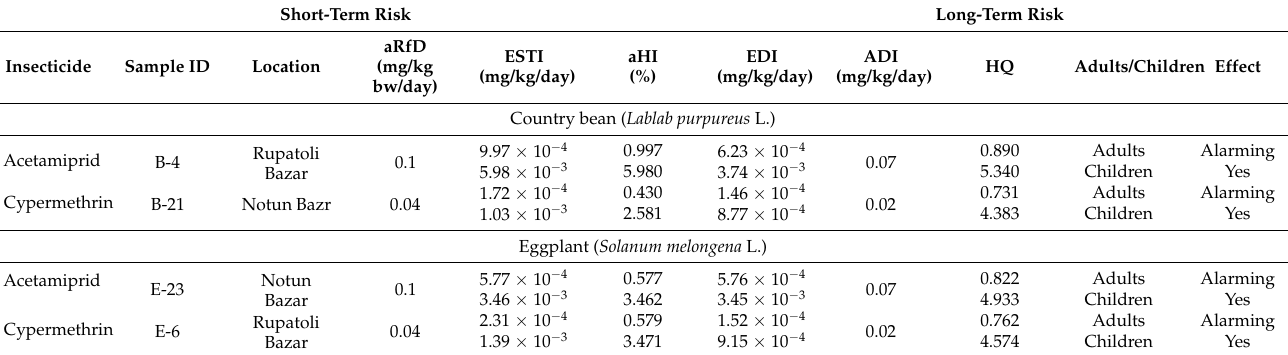
Table 3. Non-cancer acute and chronic health hazards for adults and children due to the consumption of pesticide- contaminated green